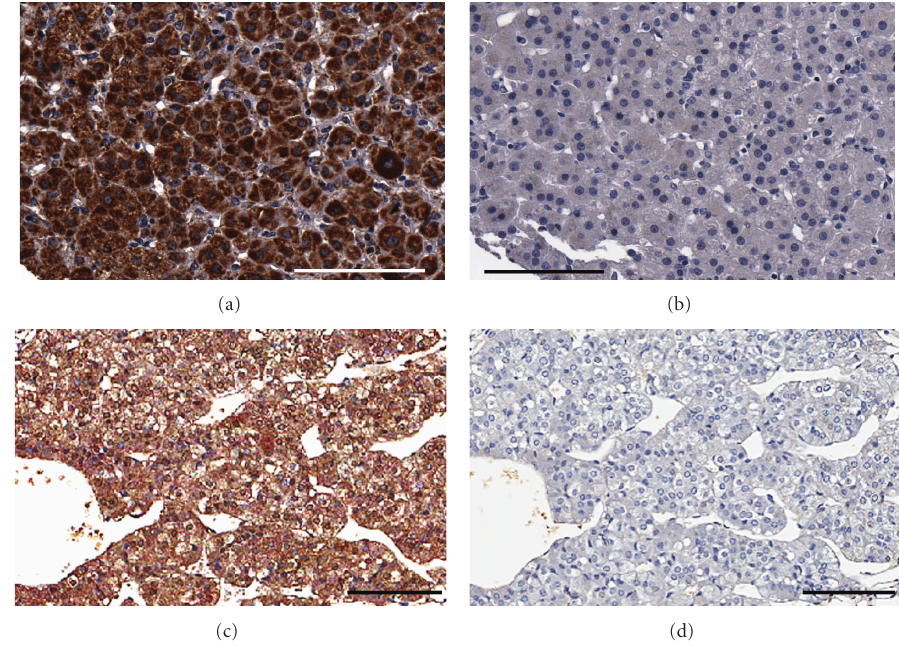
Figure 7: Expression of Plg-R KT in adrenal medulla. Human (a, b) and mouse (c, d) adrenal medulla tissue sections were stained with anti-Plg-R KT mAb, in the absence (a, c) or the presence (b, d) of the decapeptide used for immunization, CEQSKFFSDK (corresponding to the nine C-terminal amino acids of rat Plg-R KT with an amino terminal cysteine added for coupling). Positive tissues are indicated by brown staining with DAB. Scale bar = 100 μ m. [25]. ©The American Society for Biochemistry and Molecular